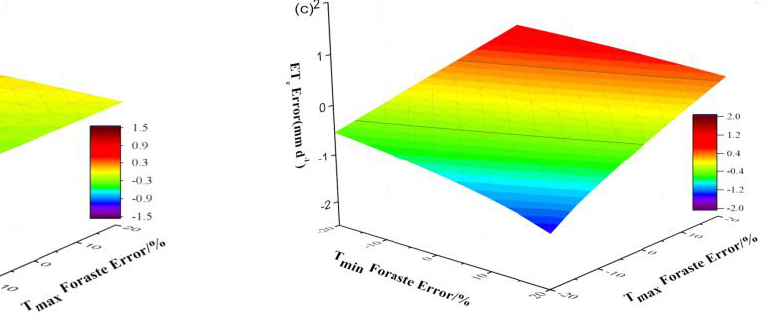
Figure 9. The influence of temperatures on ET c , for ( a ) 1-day forecast and observed temperatures; ( b ) multi-factor method on error sensitivity analysis based on T min and T max in the rainy season; ( c ) multi-factor method on error sensitivity analysis based on T min and T max in the dry